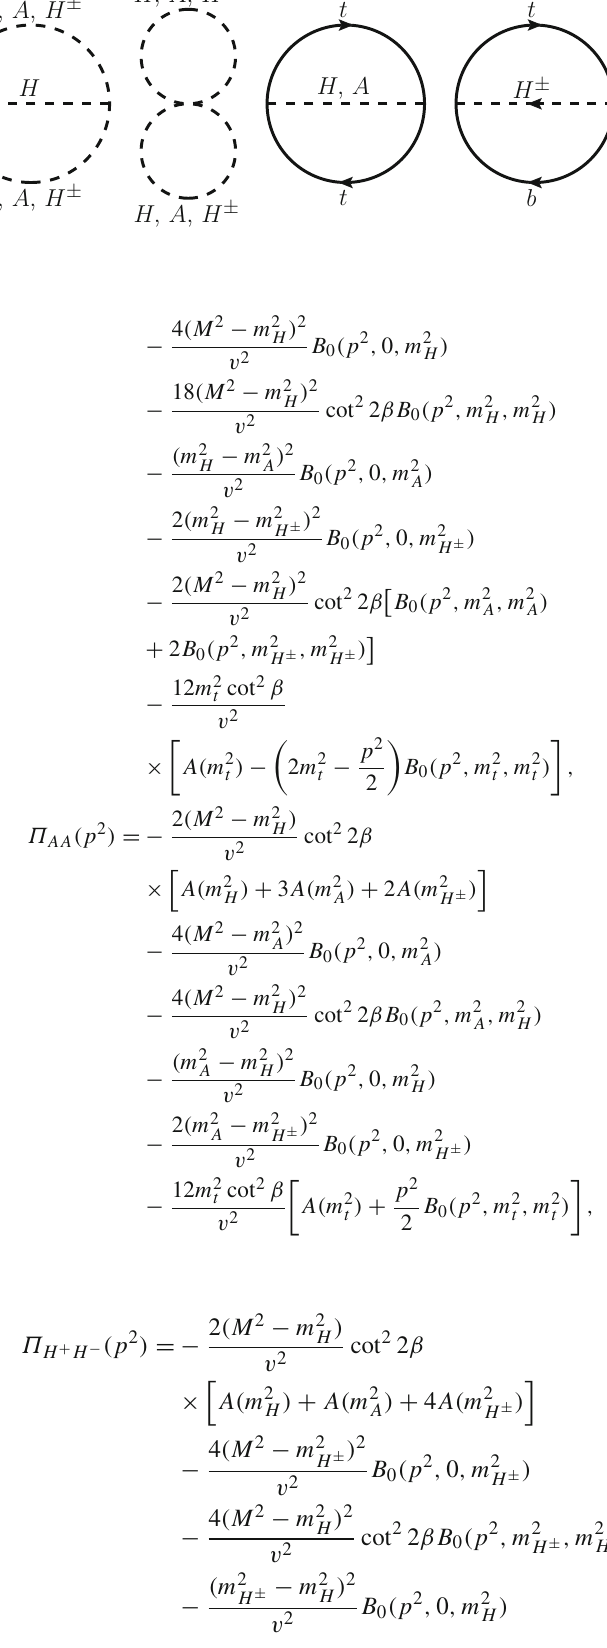
Fig. 4 Dominant two-loop diagrams contributing to the 2HDM effective potential, in the limit of degenerate BSM scalar